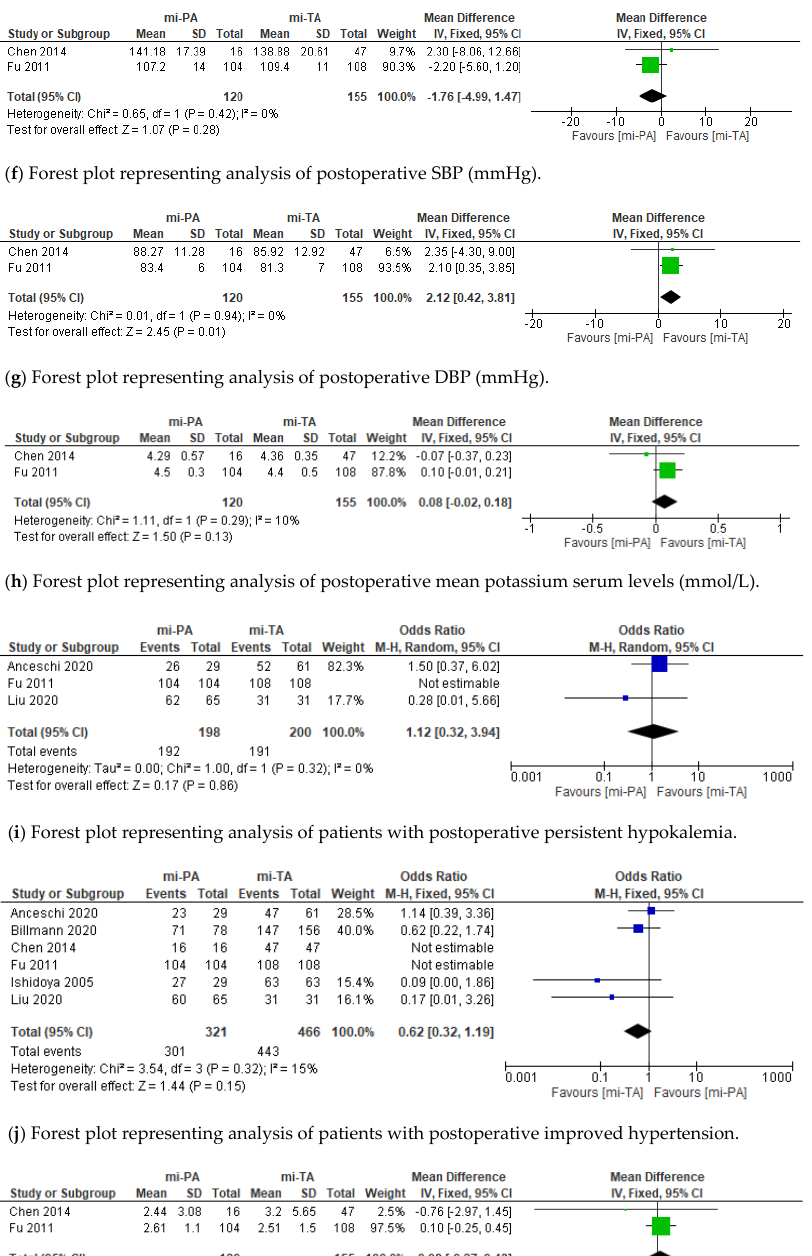
area of each square is proportional to the study ʹ s weight in the meta ‐ analysis. The meta ‐ analysed